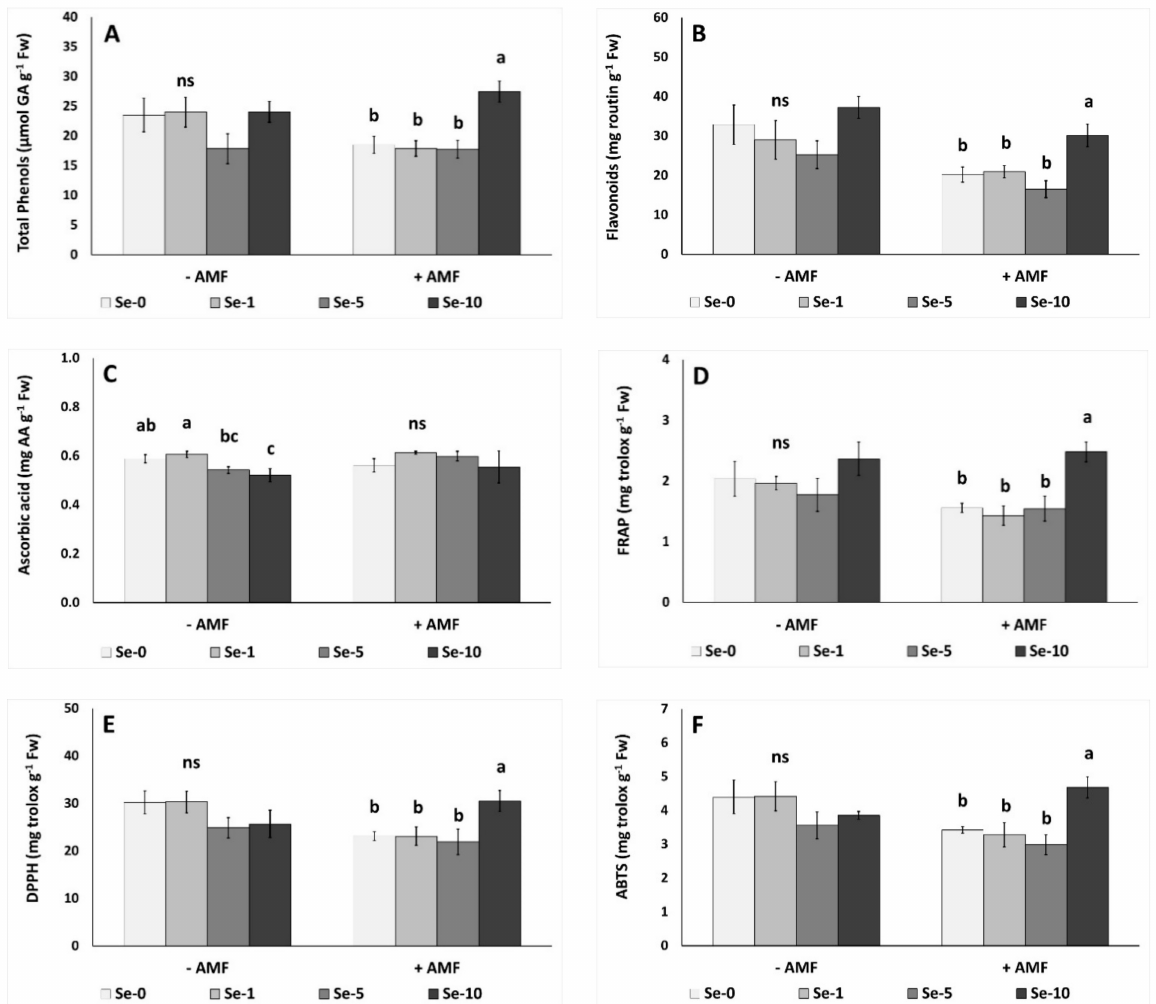
Figure 2. Effects of arbuscular mycorrhizal fungi (AMF) inoculation and selenium (Se) levels (0, 1, 5 and 10 mg L − 1 ) in the nutrient solution on fruit total phenols, flavonoids, ascorbic acid and antioxidant activity in hydroponically grown strawberries in cocosoil. ( A ) Total phenols, ( B ) flavonoids, ( C ) ascorbic acid-AA, ( D ) FRAP, ( E ) DPPH and ( F ) ABTS. Significant differences ( p < 0.05) among selenium treatments are indicated by different letters. Error bars show SE (n =